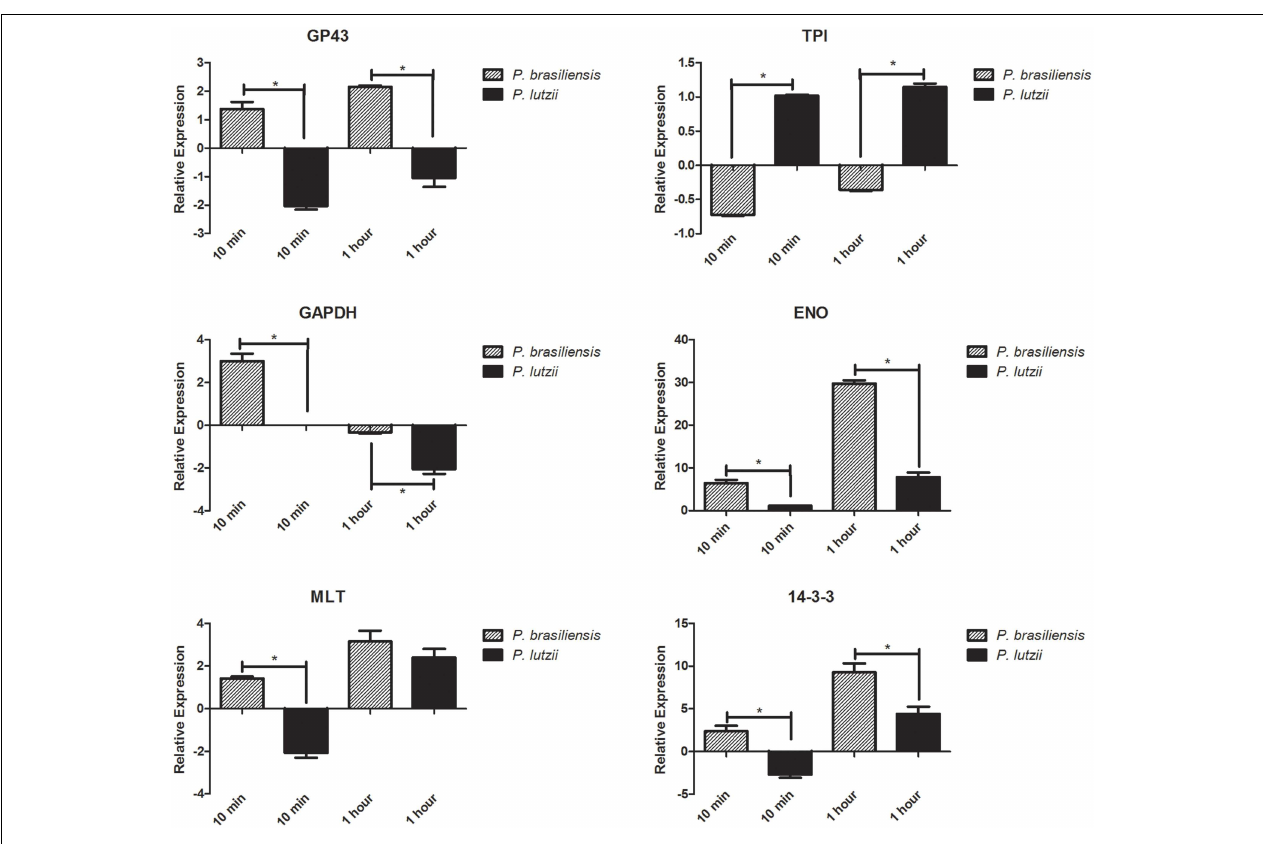
FIGURE 3 | Relative expression of adhesins. Relative expression of different genes encoding adhesins in the genus Paracoccidioides . * Indicates a statistically significant difference in expression level, p < 0 . 05 . The graphs